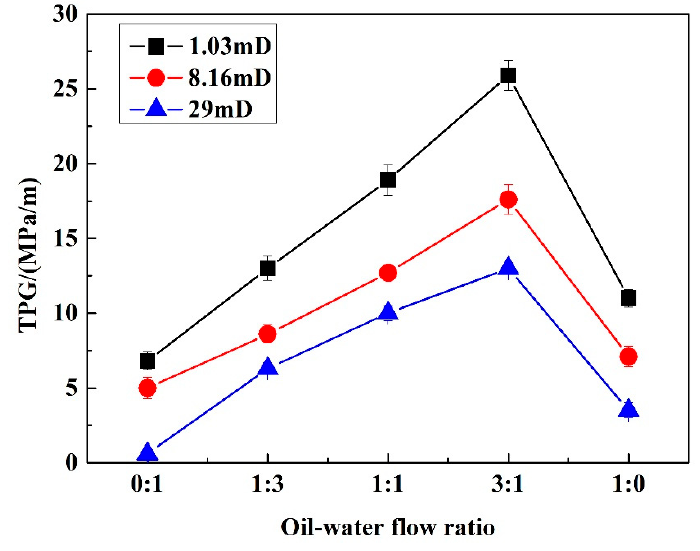
Figure 9. The TPG versus oil–water flow ratio in two-phase flow.